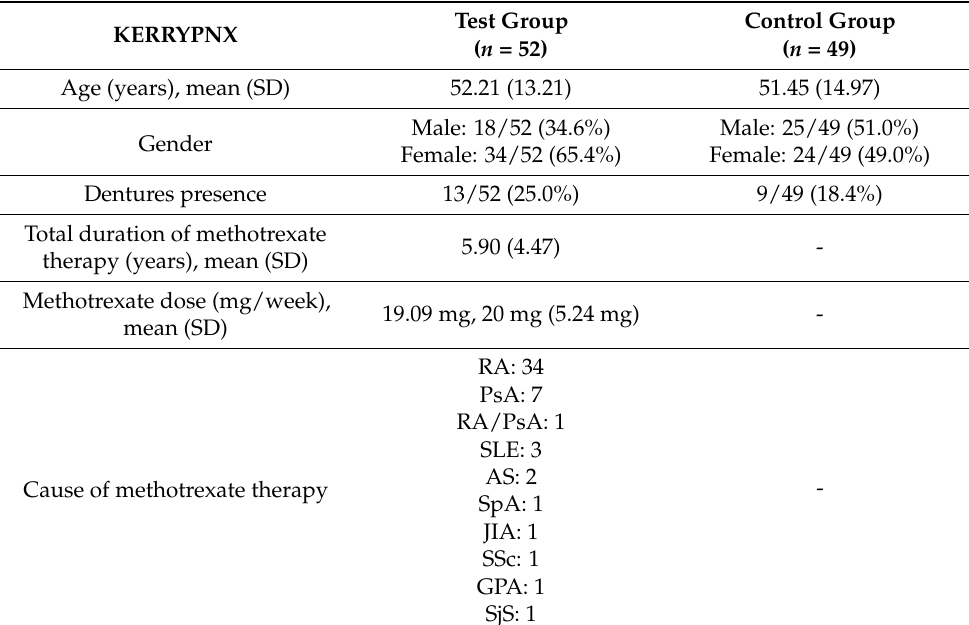
Table 1. Characteristics of the study participants. RA—Rheumatoid arthritis, PsA—Psoriatic arthritis, SLE—systemic lupus erythematosus, AS—ankylosing spondylitis, SpA—spondyloarthritis, JIA—juvenile idiopathic arthritis, SSc—systemic sclerosis, GPA—granulomatosis with polyangiitis, SjS—Sjögren’s